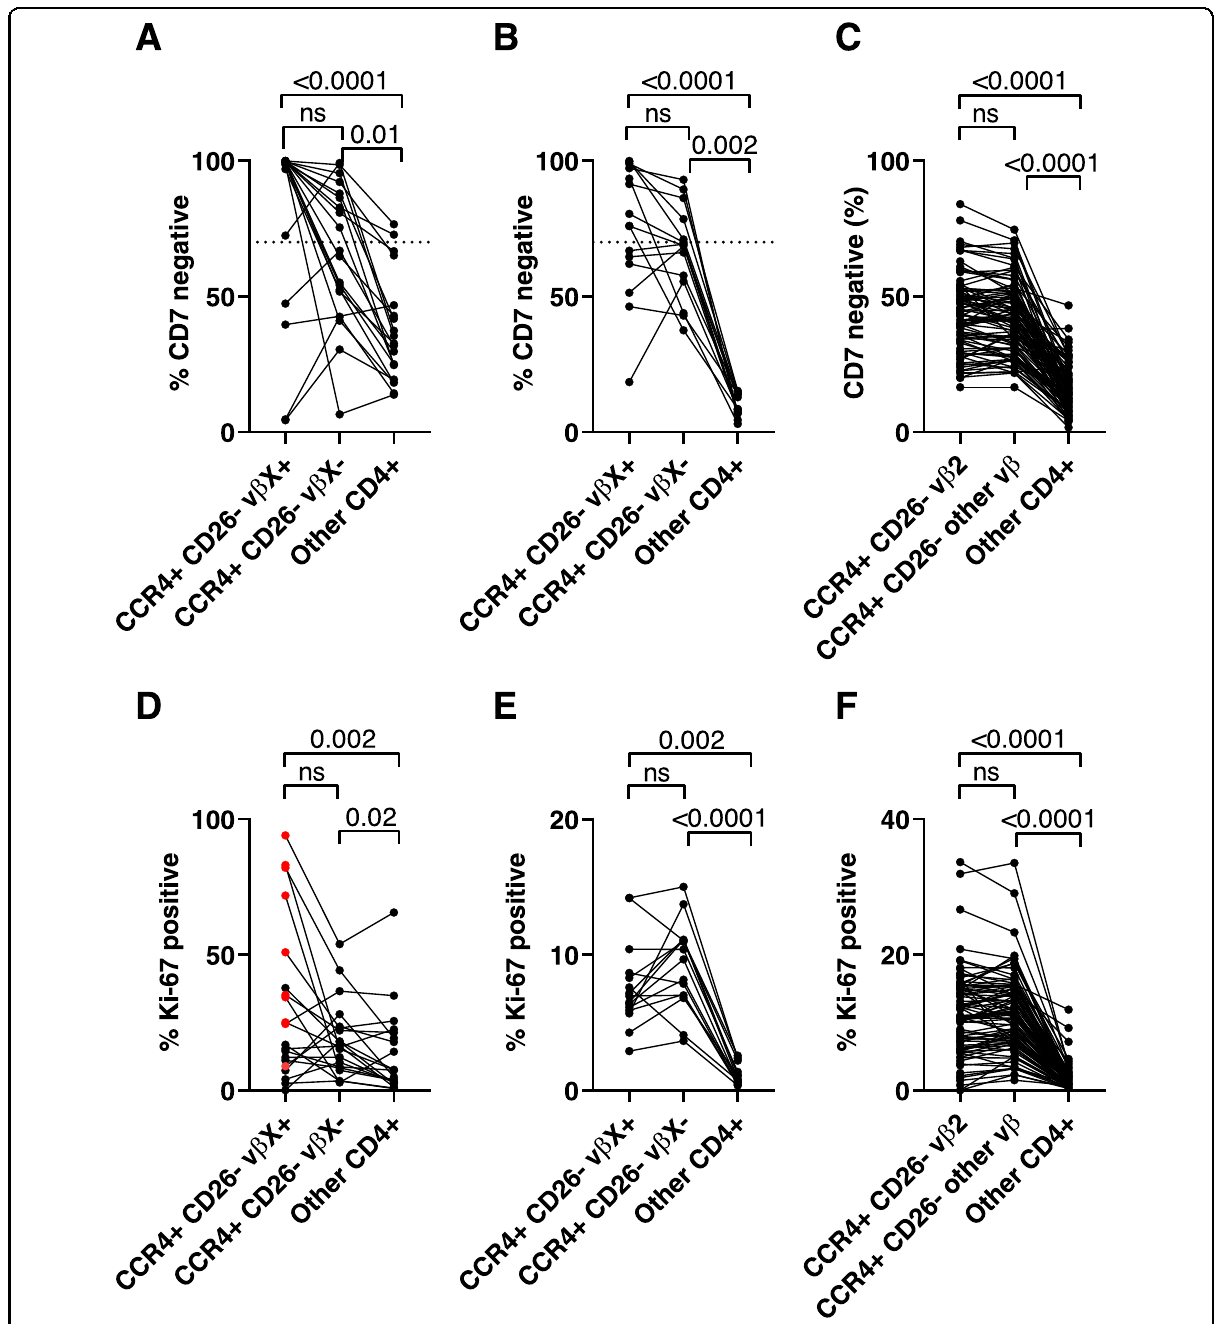
Fig. 3 Within subject analysis of expression of CD7 and Ki-67. CD4 + T cells were divided into three non-overlapping populations on the basis of TCRV β , CCR4 and CD26 expression: (1) if present, ATL-like clones were identi fi ed by gating on TCRV β X + CCR4 + CD26 − cells, (2) other HTLV-1 infected cells were identi fi ed by gating on TCRV β X − CCR4 + CD26 − cells, and (2) all remaining CD4 + T cells were designated “ Other CD4 + T cells ” . CD7 and Ki-67 expression were quanti fi ed in each population. CD7 expression in samples with OCI- fl ow >0.770 in the ATL group ( a n = 20 as 1 subject has two clones), the screening cohort ( b n = 15; as three subjects had two expanded clones and two subjects did not have populations of cells which met our criteria for an ‘ ATL-like ’ clone) and c Screening cohort subjects with OCI- fl ow ≤ 0.770 ( n = 92). Ki-67 expression in samples with OCI- fl ow > 0.770 in the ATL group ( d ) and the Screening cohort ( e ) and samples with OCI- fl ow ≤ 0.770 from the screening cohort ( f ). Statistical analysis: Friedman test with Dunn ’ s multiple comparisons